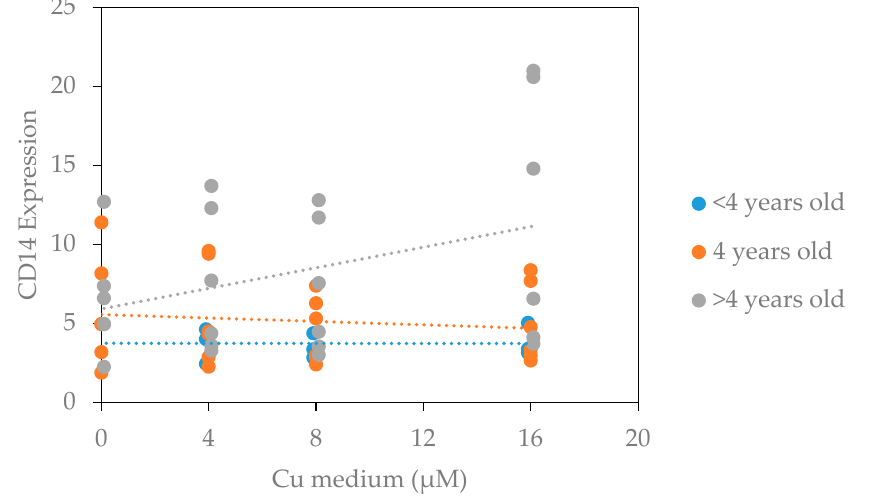
Figure 2. Association of copper levels and age on CD14 expression. PBMC incubated in the presence of increasing copper were exposed to different stimulations (media alone, PPD-A and Pam 3 CSK 4 ) for 24 h, generating 3 data points for each cow. One cow was less than 4 years, two cows aged 4 years and two cows were older than 4 years of age. Expression of CD14 and CD16 on viable monocytes were determined by flow cytometry, analysed in FlowJo and then exported to Excel and further processed in a mixed linear model using